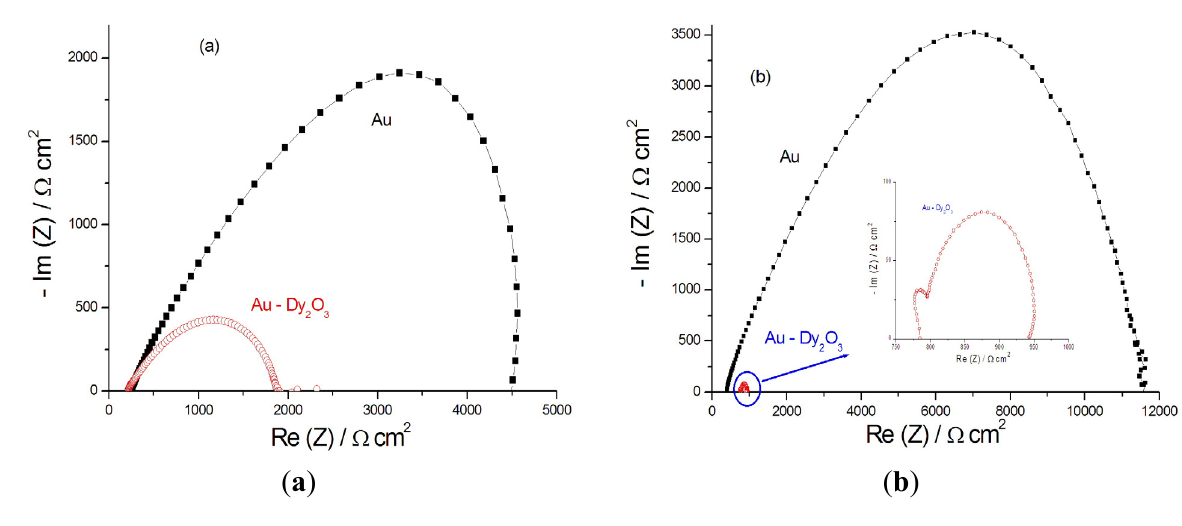
Figure 5. EIS spectra of the composite Au-Dy cell with hydrogen ( a ) or as cathode, feeding the cell with ambient air ( b ), measured at of 650 °C and applied bias potential of 1